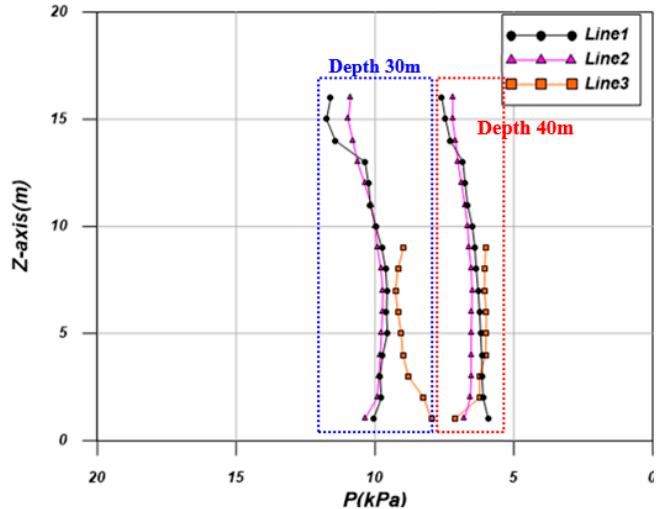
Figure 10. Comparison of the maximum dynamic wave pressure according to water depth in the numerical wave flume experiment.